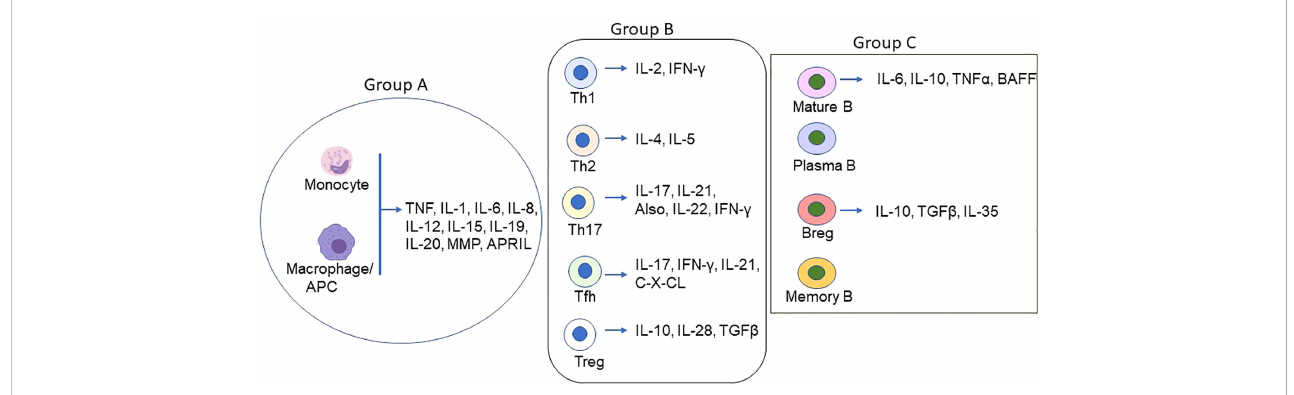
FIGURE 1 Schematic of Proin fl ammatory/in fl ammatory cytokines produced by main immune cell types in MG. Various cell types secret proin fl ammatory, in fl ammatory and in fl ammatory cytokines in addition to the groups (group A = monocytes/macrophages/DCs; group B = T lymphocytes, and group C = B lymphocytes) depicted above. The coordinated function of the cyto/chemokines prime activates DCs and AChR-speci fi c Th/B cells and the ultimate differentiation of antigen-speci fi c B cells to autoantibody-producing plasma cells and memory plasma B